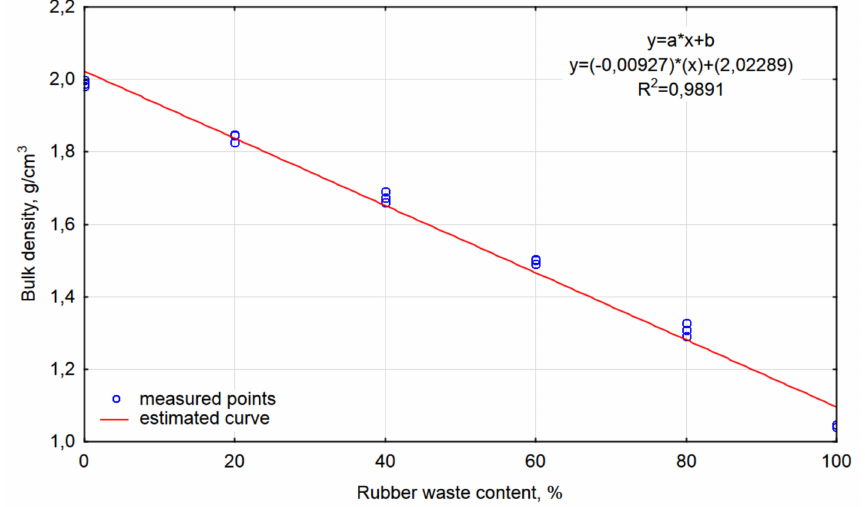
Figure 5. Graph of the function describing the dependence of bulk density on the percentage share of waste in the